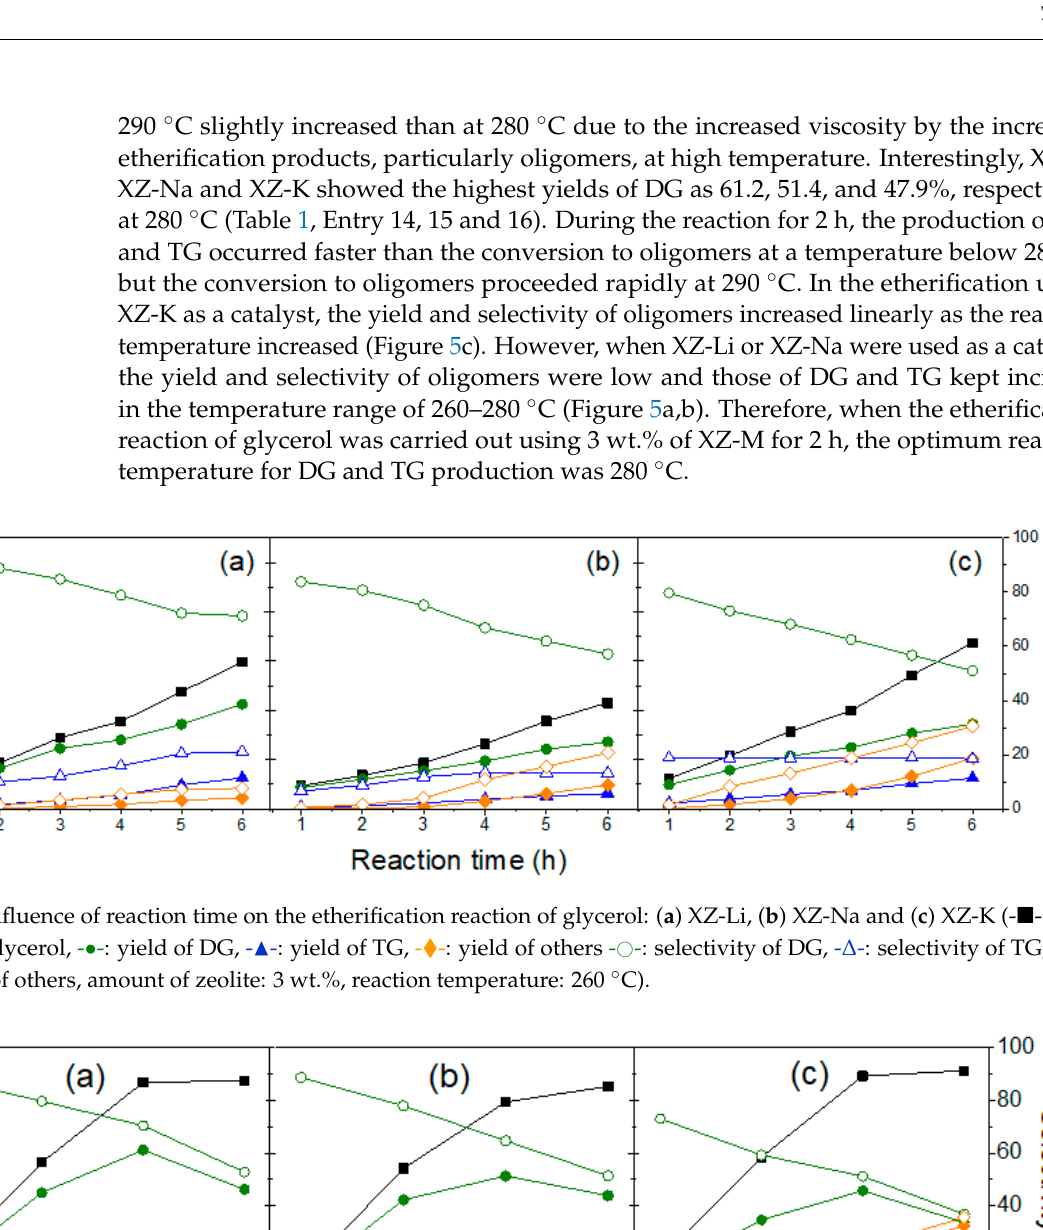
Figure 3. The influence of the amount of ( a ) XZ-Li, ( b ) XZ-Na and ( c ) XZ-K on the etherification reaction of glycerol (- ■ -: conversion of glycerol, - ● -: yield of DG, - ▲ -: yield of TG, - ♦ -: yield of others - ○ -: selectivity of DG, - Δ -: selectivity of TG, -  -: selectivity of others, reaction temperature: 260 °C, reaction time: 6 h).